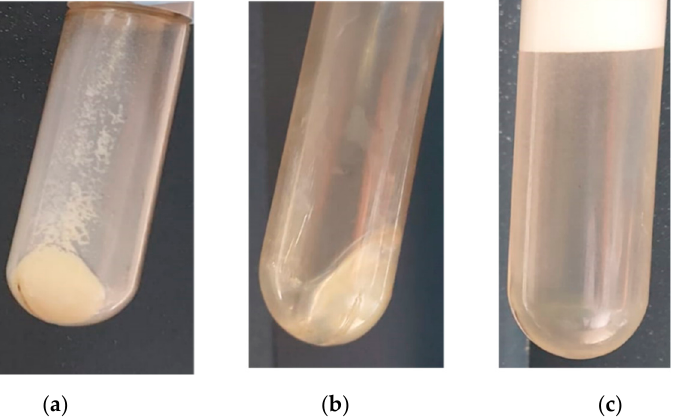
Figure 3. Visualization of bovine serum albumin nanoparticles obtained by the desolvation method, using ethanol as a desolvating agent (BSA NPS(2)): ( a ) the first centrifugation, ( b ) the second centrifugation and ( c ) the third centrifugation.